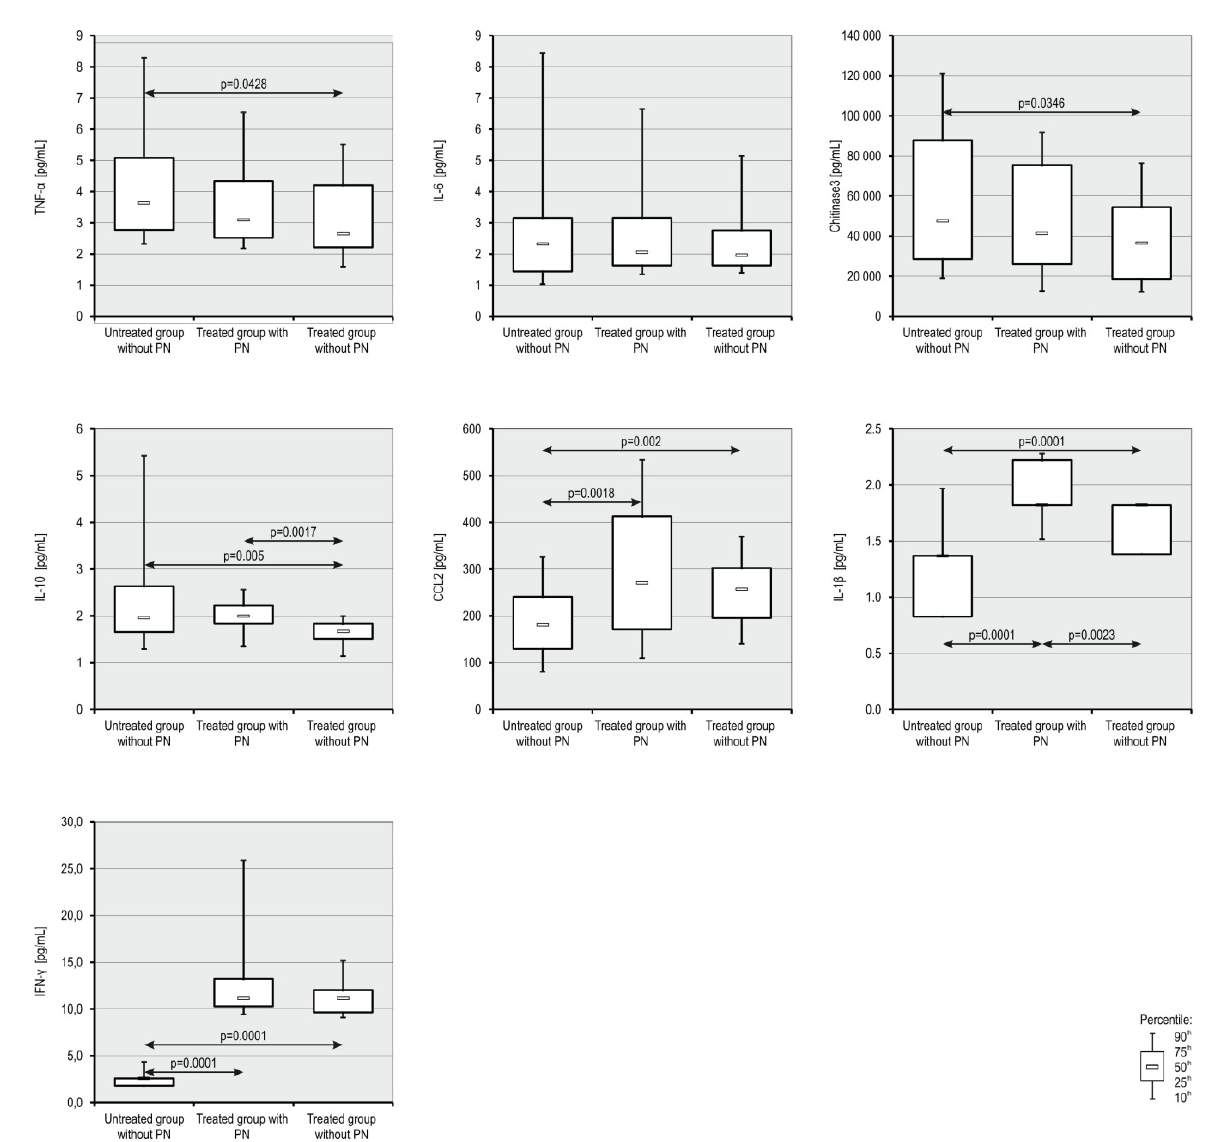
Figure 4. Box and whisker plot of concentrations of selected proinflammatory factors in patients with MM. The boxes extend from the 25th percentile to the 75th percentile; the whiskers represent the 90th percentile and 10th percentile coefficients and the small black box indicates the concentration median.